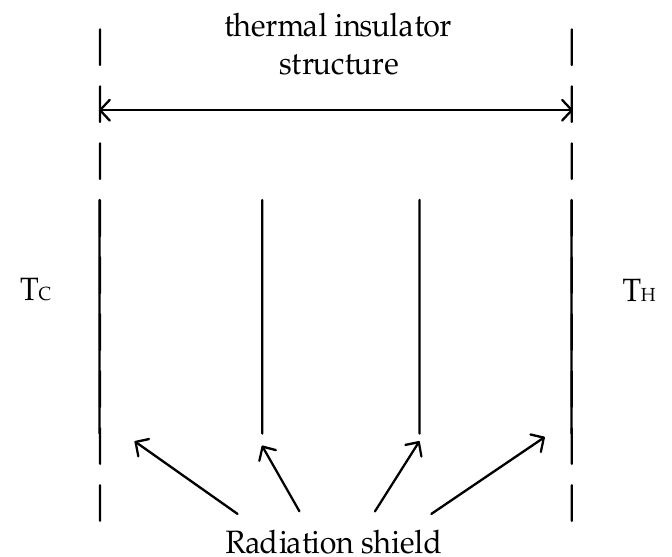
Figure 2. Schematic of the sub-region structure.